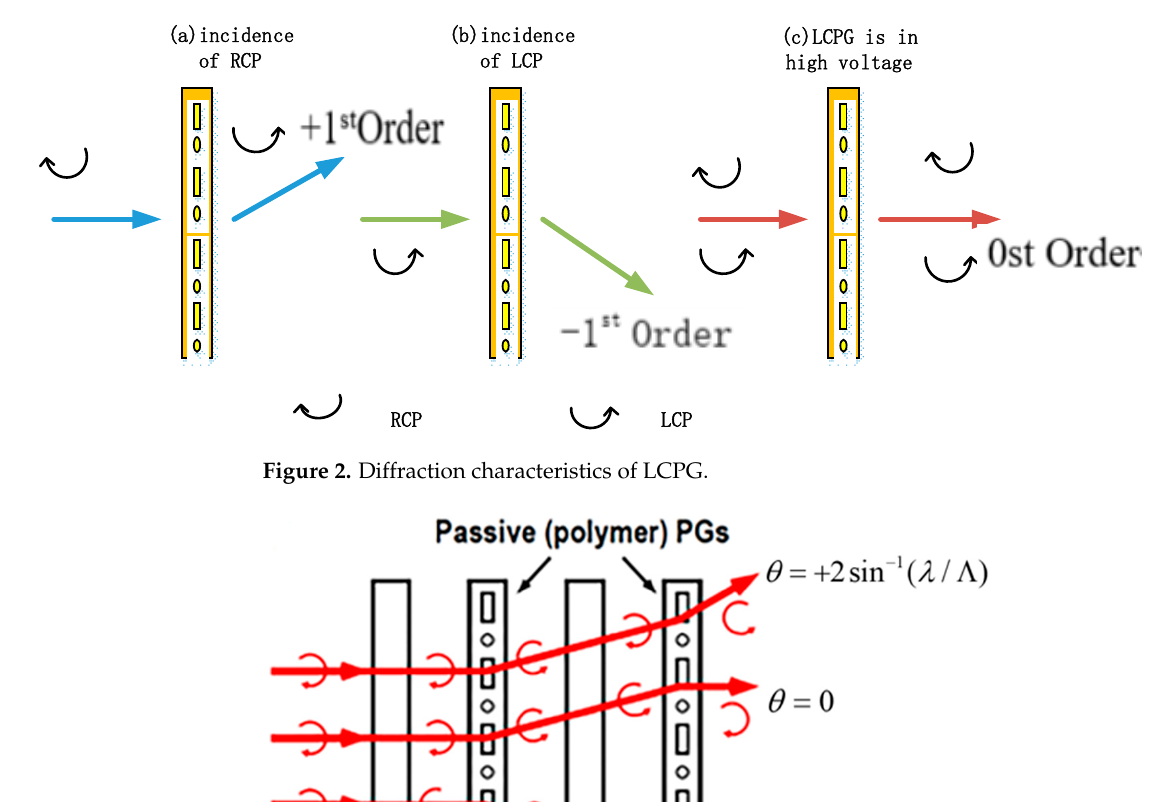
Figure 3. According to the curve between the diffraction efficiency and the incidence angle, the diffraction efficiency will decrease with the increase in the incidence angle. According Figure 2. Diffraction characteristics of LCPG. to its research results, the diffraction efficiency will decrease.